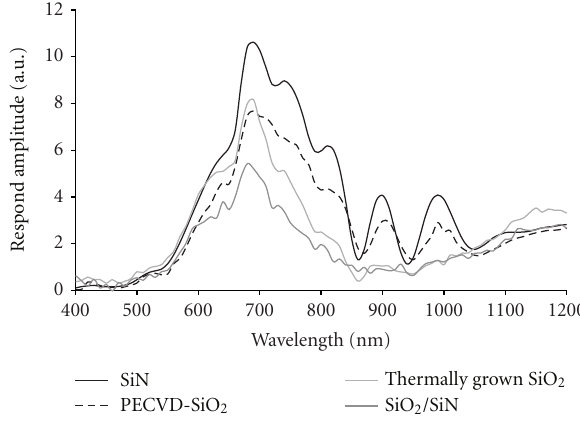
Figure 3: Results of Surface photovoltage (SPV) measurement of various antireflection coatings (ARCs).